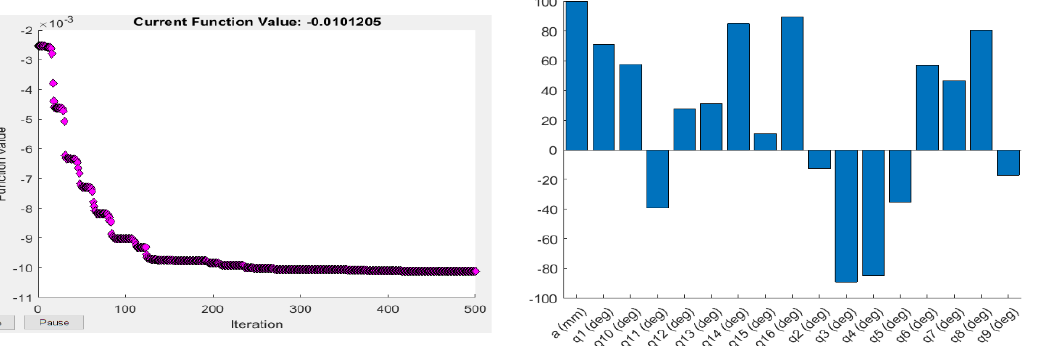
Figure 5. Objective function values ( left ), and the corresponding optimised joint parameters ( right ) for the best objective function value obtained by Fmincon for the LCI manipulability